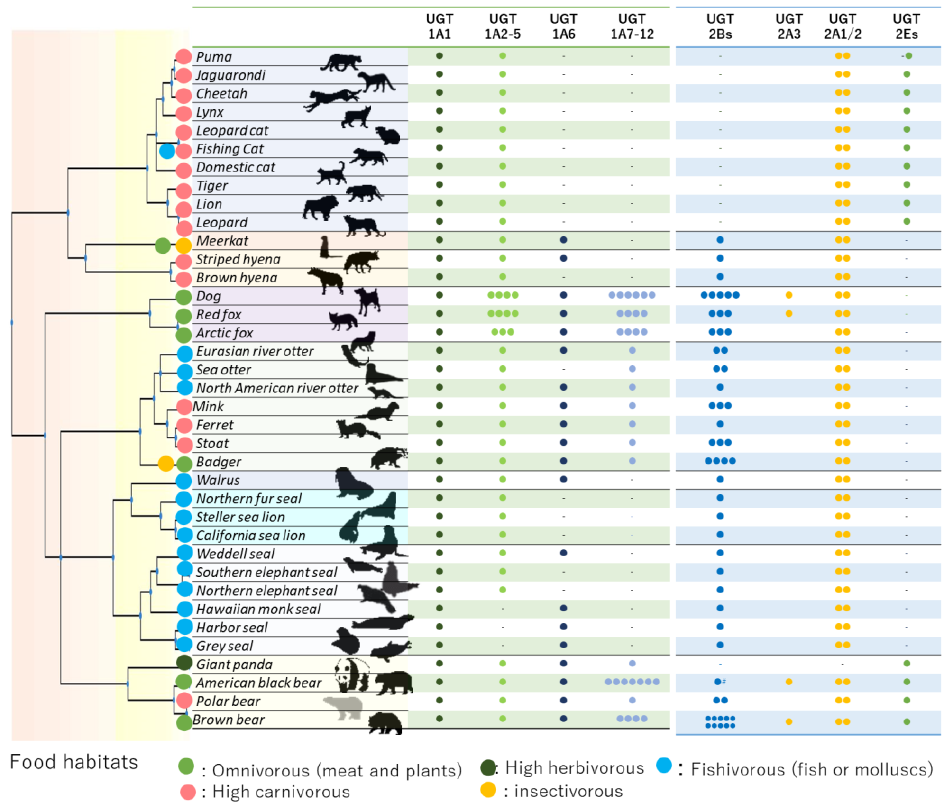
Figure 1. Gene numbers for UGT1A, 2A, 2B, and 2C/E are shown by number of small filled circles. Large filled circles next to the scientific name of each species are colored by known diet. In brown bear (Ursus arctos), we detected three coding loci and all isoforms except “partial” or “low quality” were counted in this case. In black bear, we omitted six other partially coded genes. The phylogenetic tree was created with TimeTree 5 [23]. Manually curated unannotated isoforms, in badger, ferret, and sea otter, respectively, were also counted in this table.